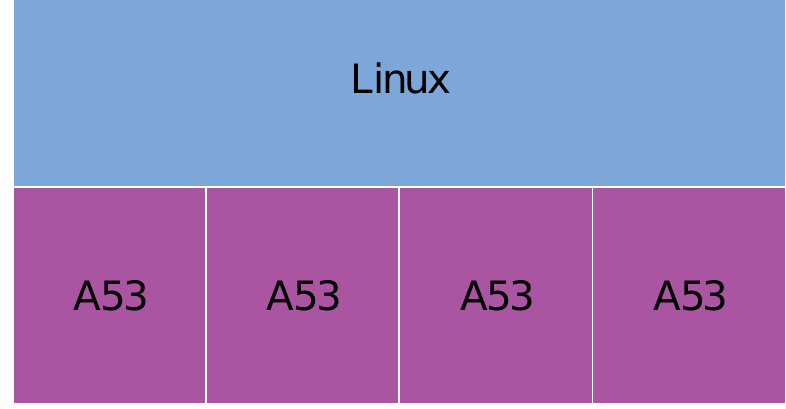
Figure 1. Scenario 1: Linux OS.